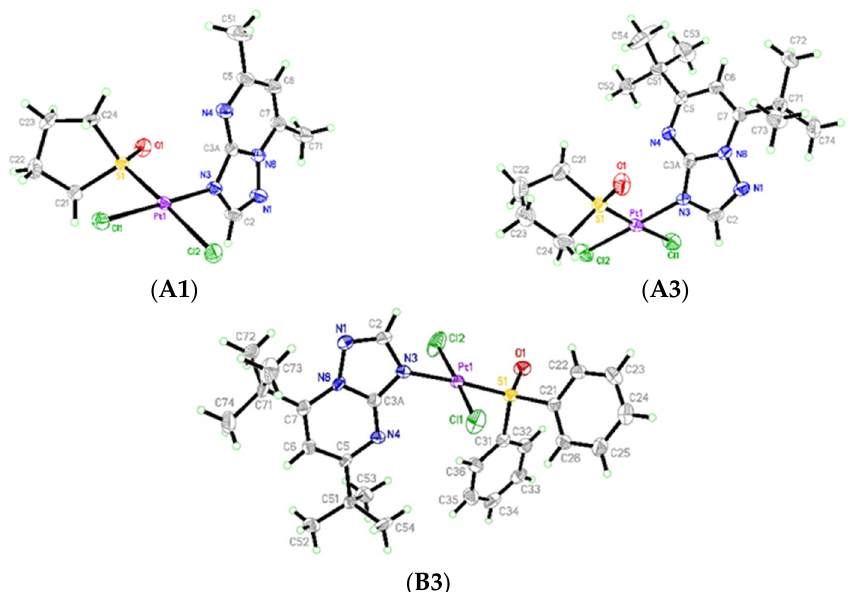
Figure 2. Crystal structure of cis -[PtCl 2 (dmtp)(TMSO)] ( A1 ), cis -[PtCl 2 (dbtp)(TMSO)] ( A3 ) and trans- [PtCl 2 (dbtp) (DPSO)] ( B3 ).